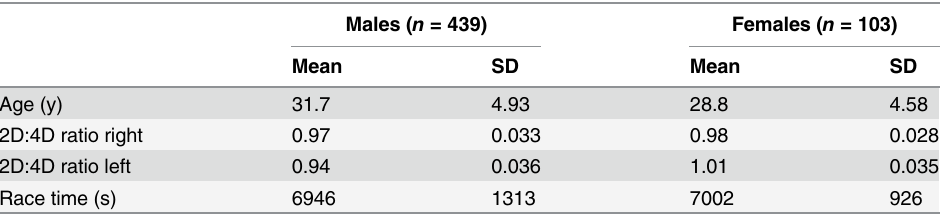
Table 1. Descriptive characteristics of the samples.